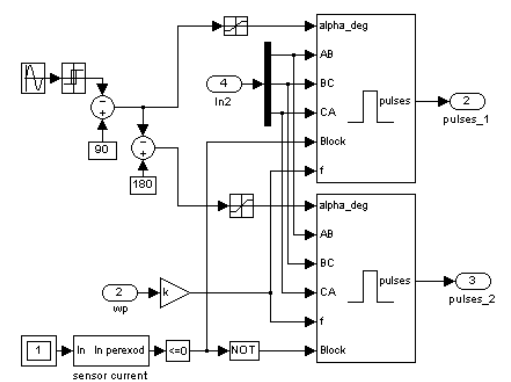
Figure 6. Simulation model of control system